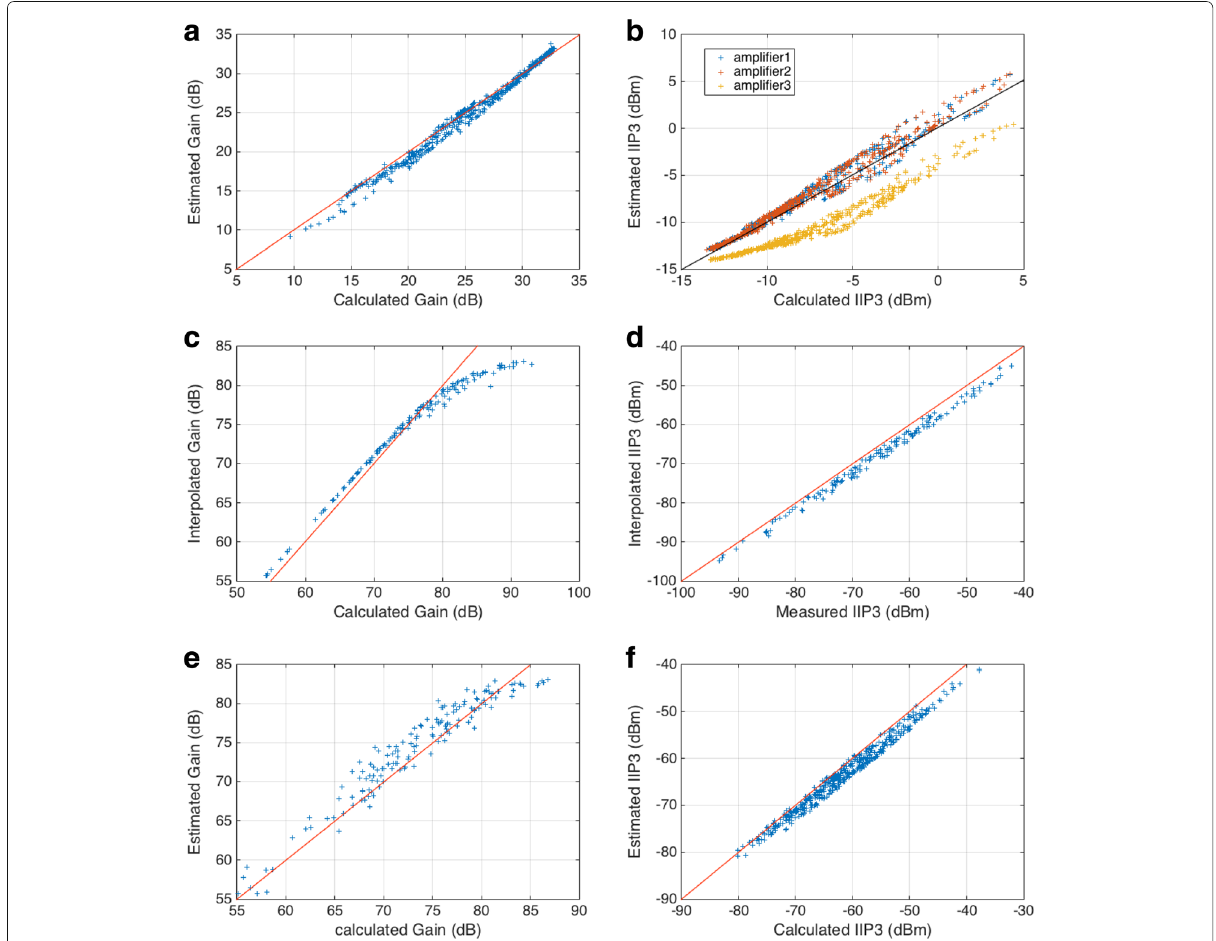
Fig. 9 Simulation results of the interpolation method. a Interpolated gain of an amplifier. b Interpolated IIP 3 of an amplifier. c Estimated gain of a configuration with three amplifiers using interpolated gain. d Estimated IIP 3 of a configuration with three amplifiers using interpolated IIP 3 . e Estimated gain of a configuration using simulation. f Estimated IIP 3 of a configuration using simulation